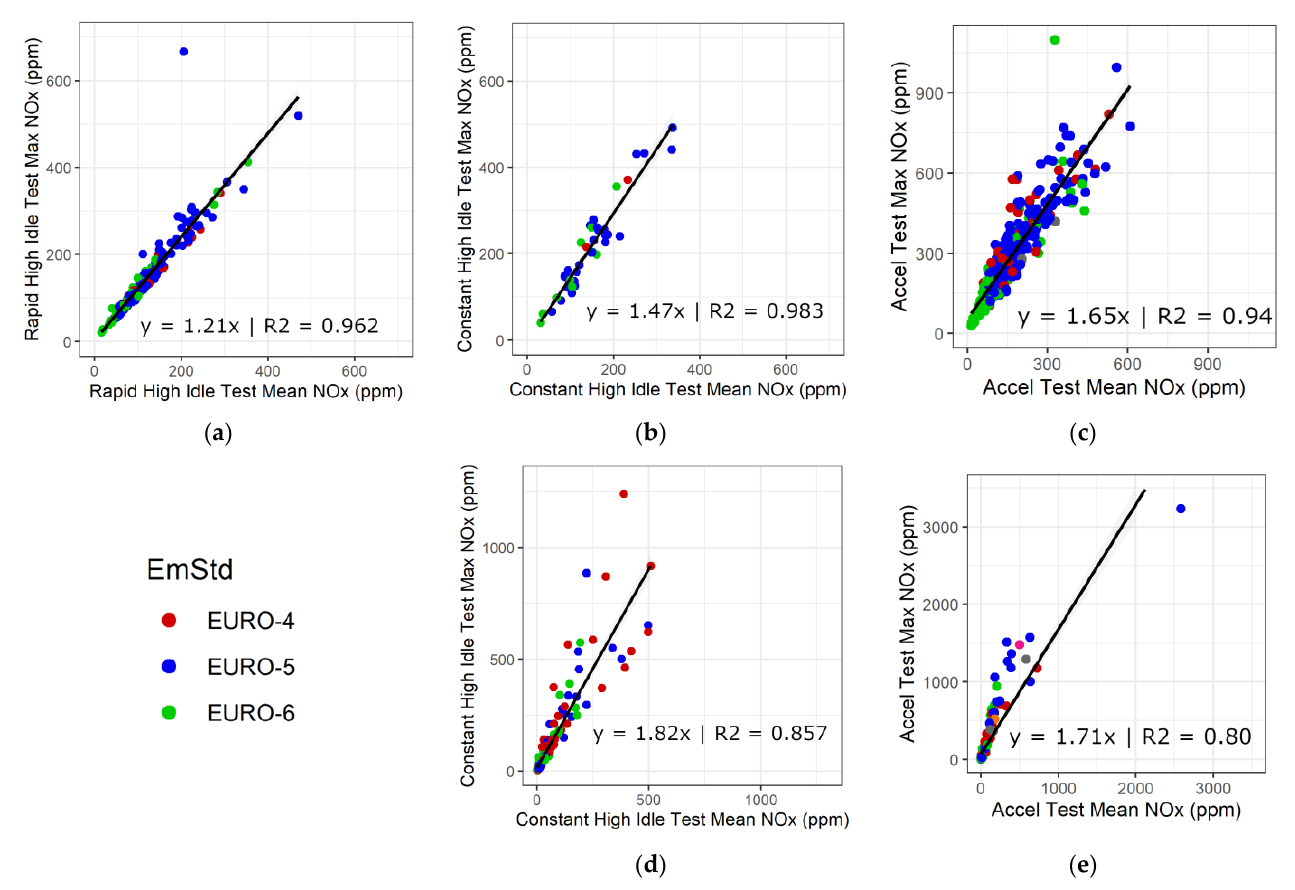
Figure 4. Petrol and diesel maximum NOx concentration versus mean NOx concentration for high idle and acceleration test sections: ( a ) diesel vehicle rapid high idle test; ( b ) diesel vehicle constant high idle test; ( c ) diesel vehicle acceleration test; ( d ) petrol vehicle constant high idle test; ( e ) petrol vehicle acceleration test.